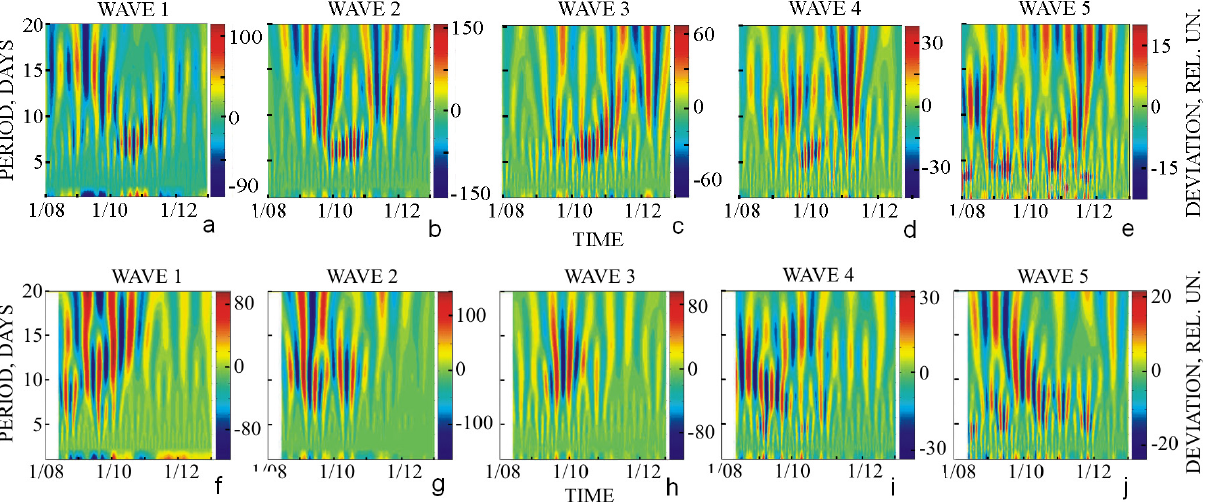
plitude of about 69 and 93 DU, respectively, see Fig.